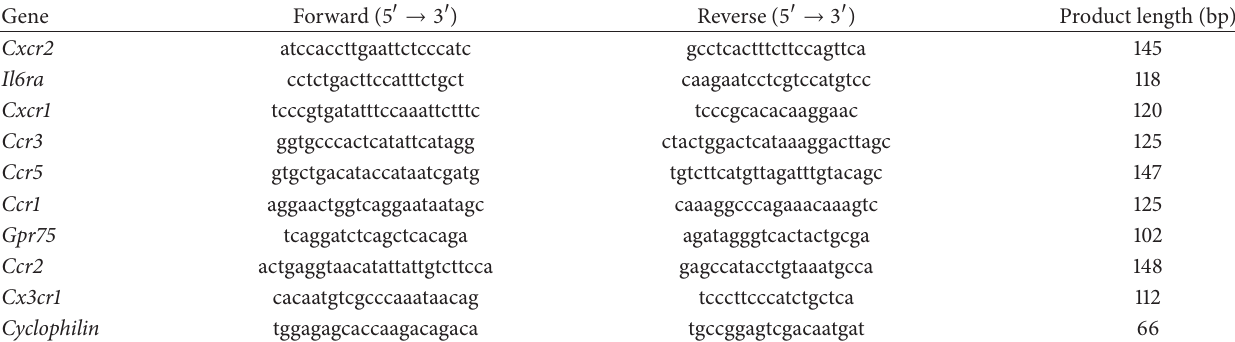
Table 1: Sequences of forward and reverse primers used for PCR